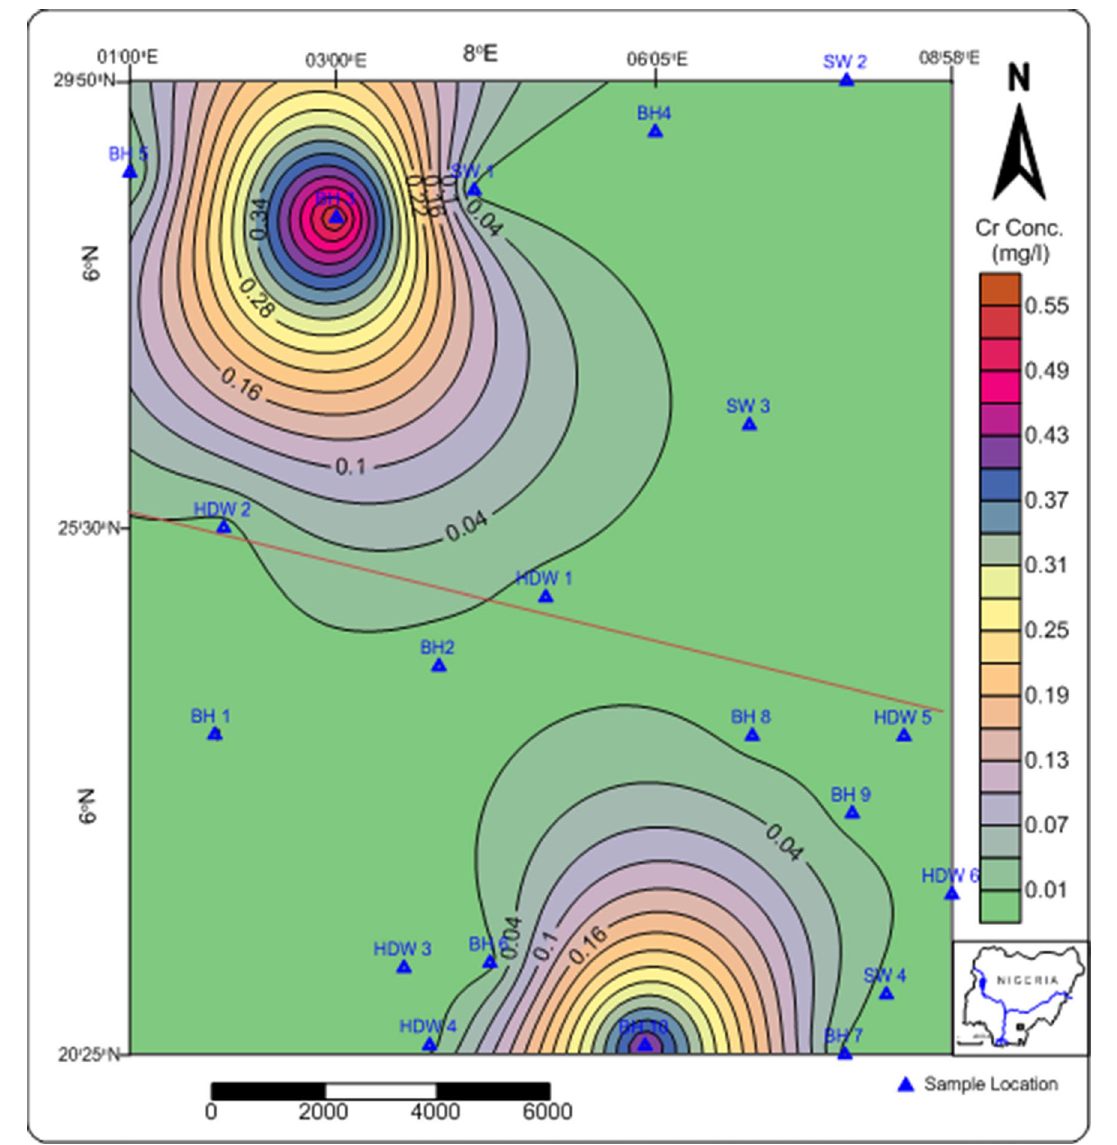
Fig. 18 Map for dispersion of chromium. Note : Perpendicular line indicates groundwater